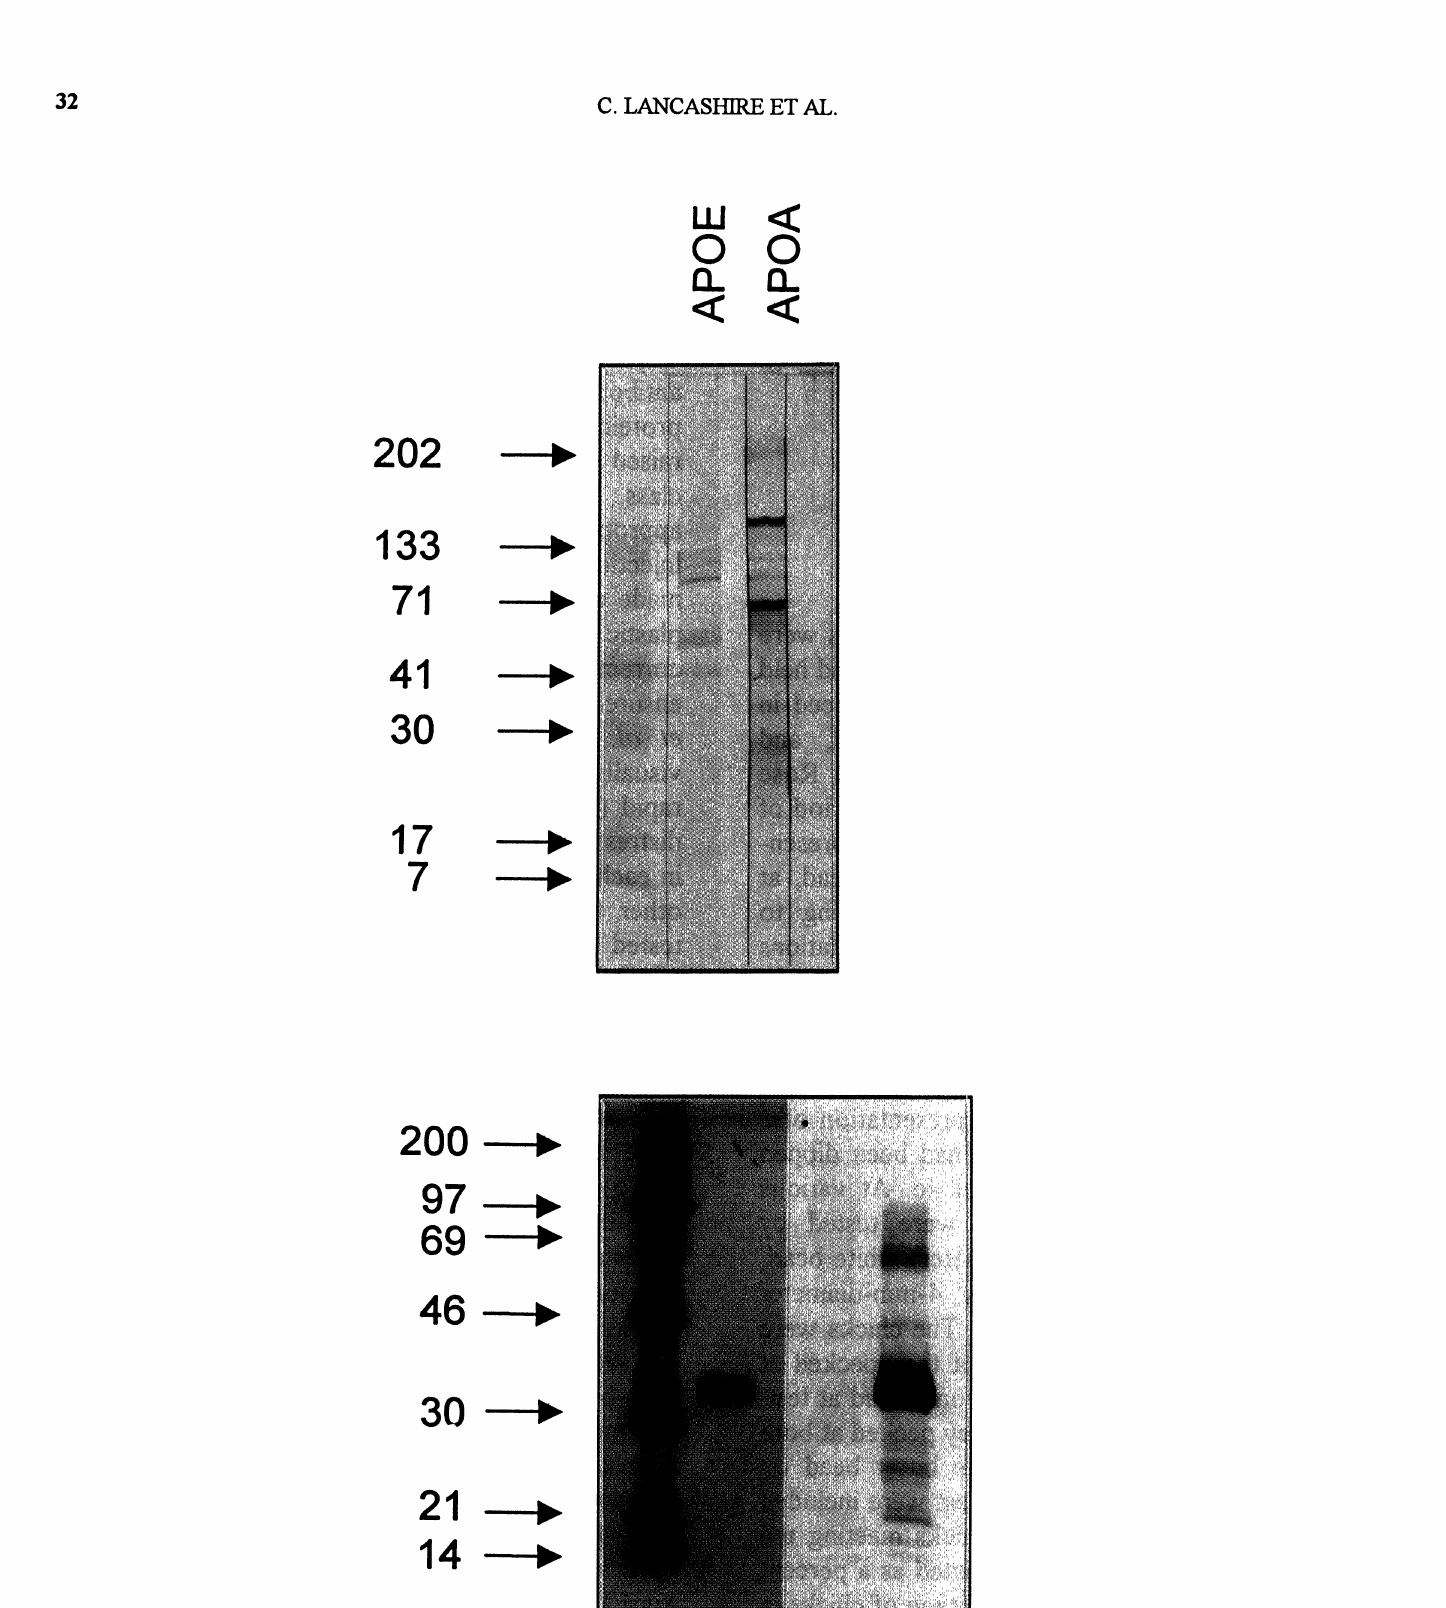
Fig. 1: (a) Immunorcactivity of ApoE and Apo-A-I antibodies with SPM proteins. SDS-PAGE and Western immunoblotting were performed as described in the Experimental section. Each track contained 50 gg of SPM protein from day--ld forebrain. Lane 1" Rainbow standard; Lane 2" anti-ApoE (30 gg/ml); Lane 3" anti-ApoA-I (20 gg/ml). Co) SDS-PAGE and Western blot f authentic human Apo-E. Lane 1" Rainl:w standard; Lane 2" SDS-PAGE of ApoE; Lane 3" Western blot of ApoE with monoclonal anti-human Apo-E antibodies (2.5